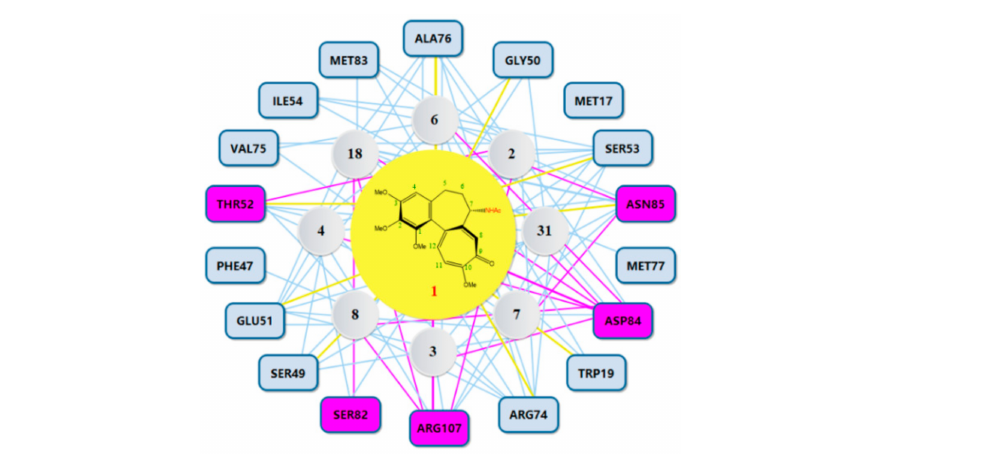
Figure 5. Network diagram illustrating the principal amino acid residues involved in interactions between COL and its metabolites and ZO-1. Purple rectangles represent residue involved in hydrogen bonding. Yellow lines represent residues interacting with COL. Table 2. Molecular docking statistics for interaction between ZO-1 and COL with its